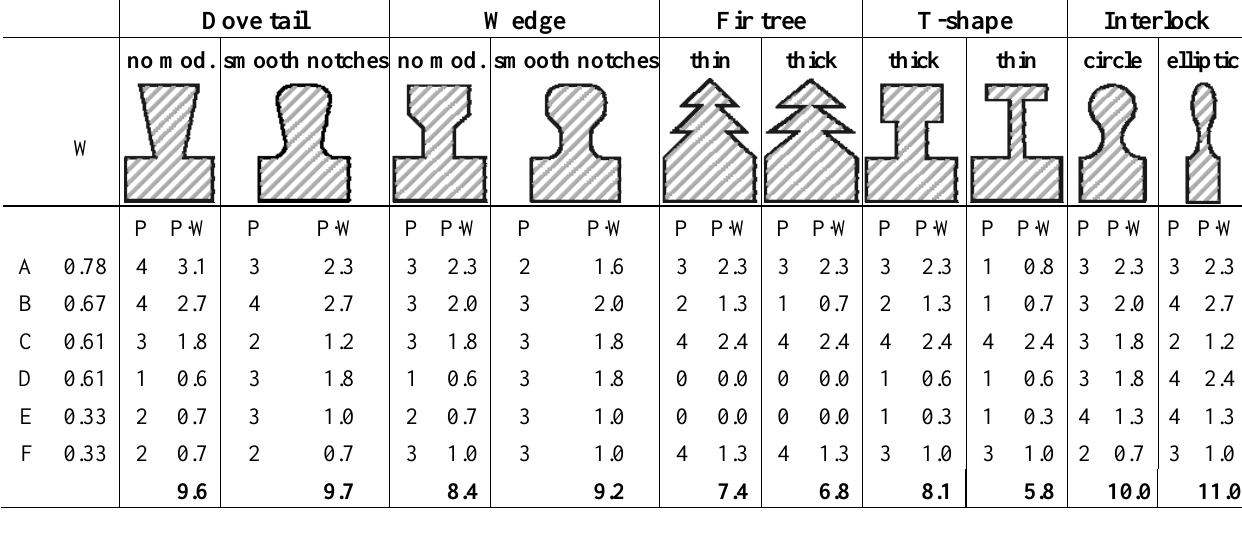
Table 2. Evaluation of the elementary designs for undercutting elements. Dove tail Wedge Fir tree T-shape Interlock no mod. smooth notches no mod. smooth notches thin thick thick thin circle elliptic